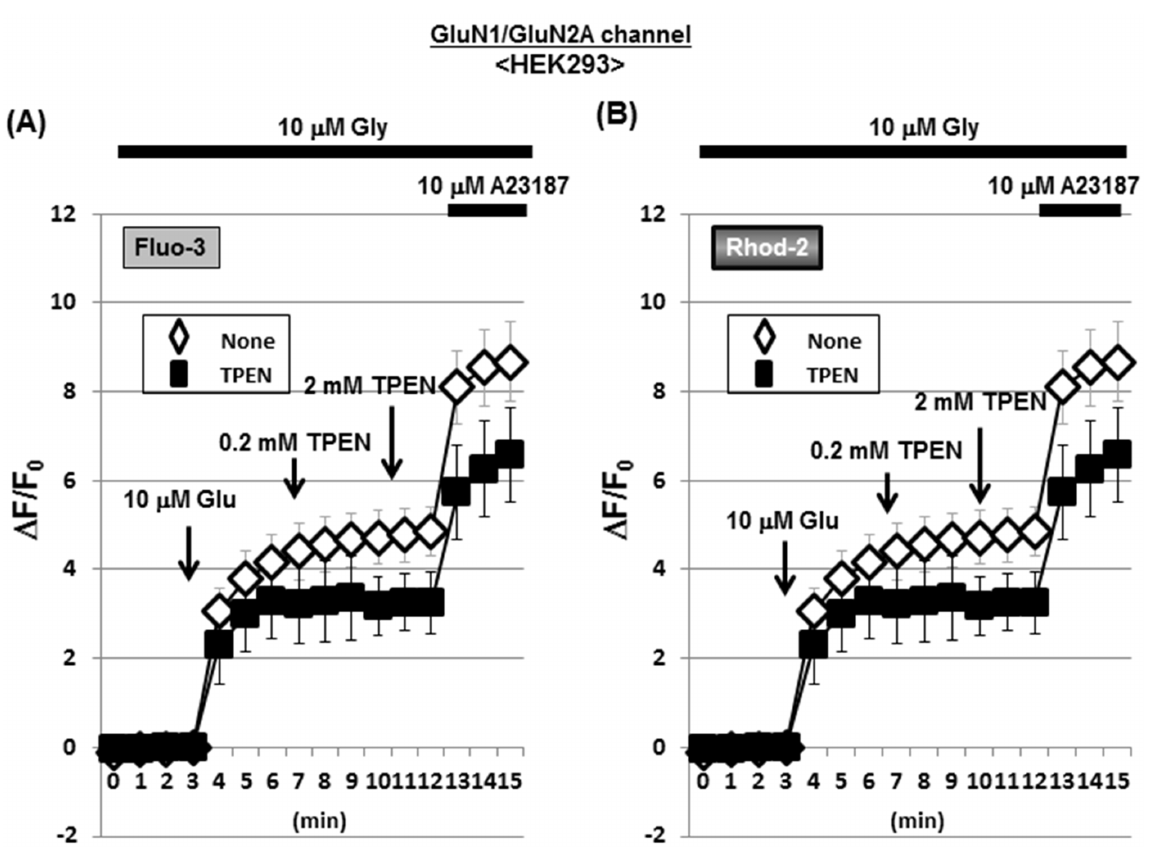
Fig 10. Effects of TPEN on Fluo-3 and Rhod-2 fluorescence in HEK293 cells with acquired NMDAR channels. HEK293 cells were transfected with expression vectors of GluNR1 and GluNR2A, followed by further culture for an additional 24 h and subsequent loading of either (A) Fluo-3 or (B) Rhod-2 in the presence of Gly. Cells were then exposed to Glu in either the presence or absence of TPEN during the determination of each fluorescence intensity every 1 min. Values are the mean ± S.E. of the rate of fluorescence change in 3 different experiments.